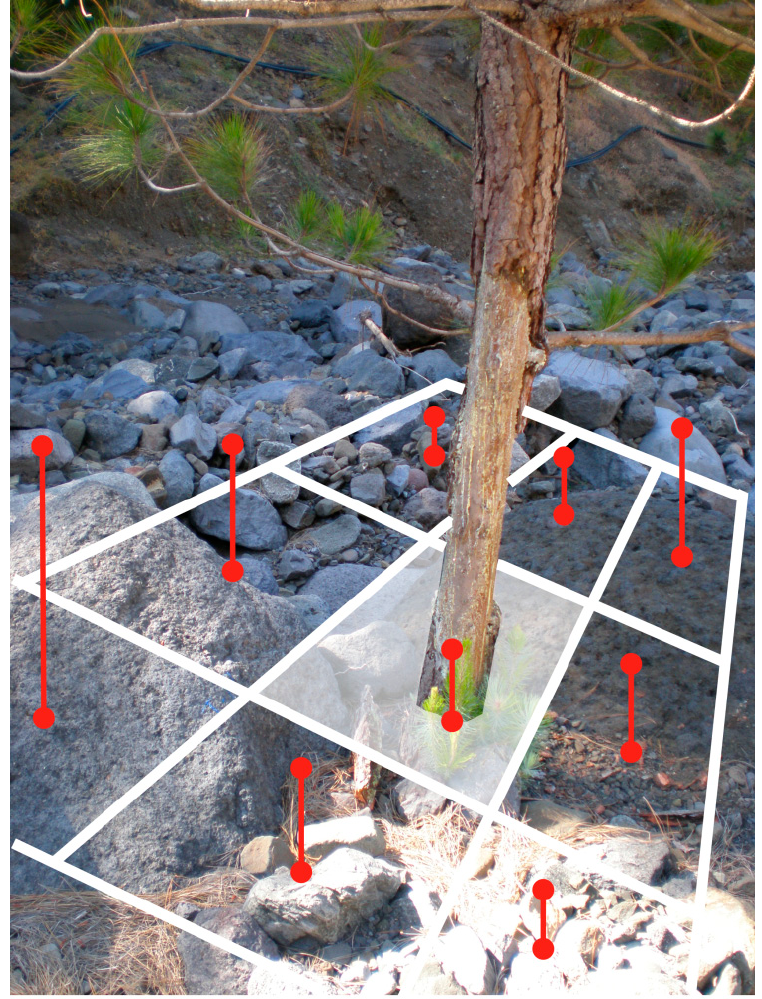
Figure 9. Sketch of the buffer approach followed for the sensitivity analysis of the peak flow estimation results against the location of dendro-geomorphological evidence. Red lines show the elevation variability inside the buffer area.